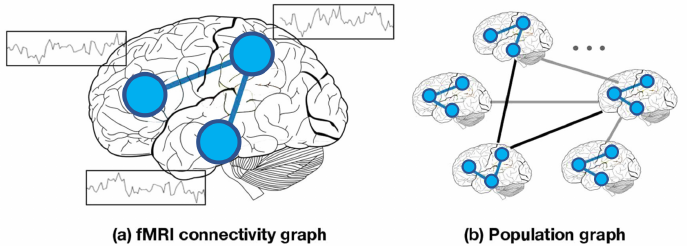
Figure 3. Proposed graph-based approaches for modeling with rs- f MRI data. Image taken from [40].